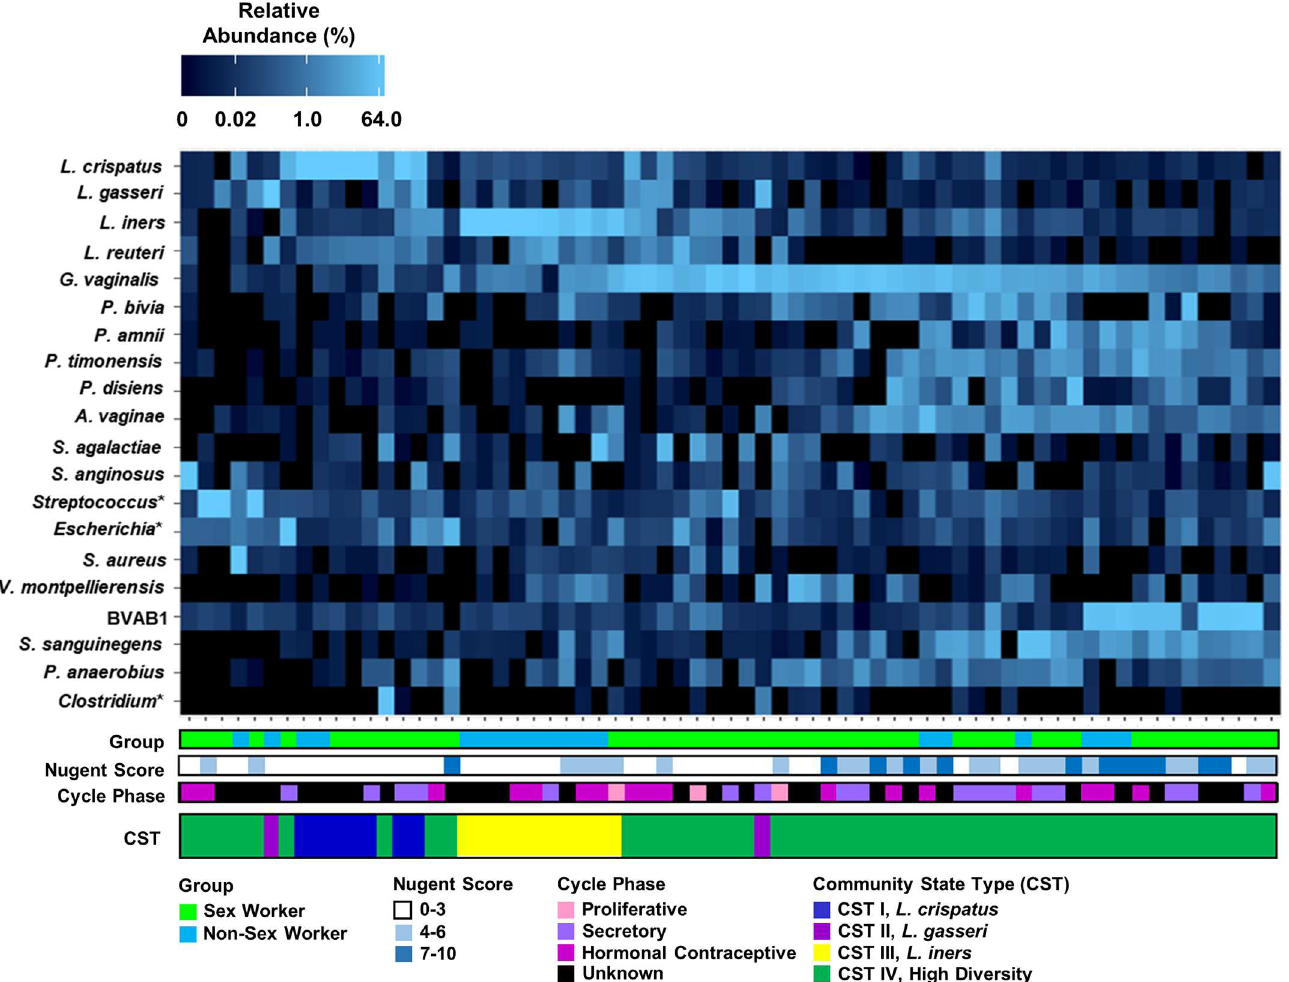
Fig 4. Heatmapreveals clustering patterns based on community state types. A heatmap of the top 20 species basedon Bray-Curtis dissimilarity distanceand PCoA ordinationrevealed that the vaginalmicrobiota(columns)of Non-Sex Workers (NSW), and Female Sex Workers (FSW) did not cluster independently, but clusteredby community state type (CST). CSTI consisted of women who were L . crispatus dominant (blue, N = 7/67), CSTII were women who were L . gasseri dominant (purple, N = 2/67), CSTIII were L . iners dominant (yellow, N = 10/67), and CSTIV was women with highly diverse vaginalmicrobiota (green, N = 48/67). All of the women with Nugent Scores 7–10 (dark blue) clusteredtogether in the most diverseCST, regardlessof which group (NSW, or FSW) they belongedto. None of the women who were L . crispatus , or L . gasseri dominant had Nugent scores between4 and 6, but 4 of the women who were L . iners dominant had Nugent scores between4 and 6. Group, Nugent Score, menstrualcycle phase, and CST are listed below each column. * : resolvedto bacterialgenus.